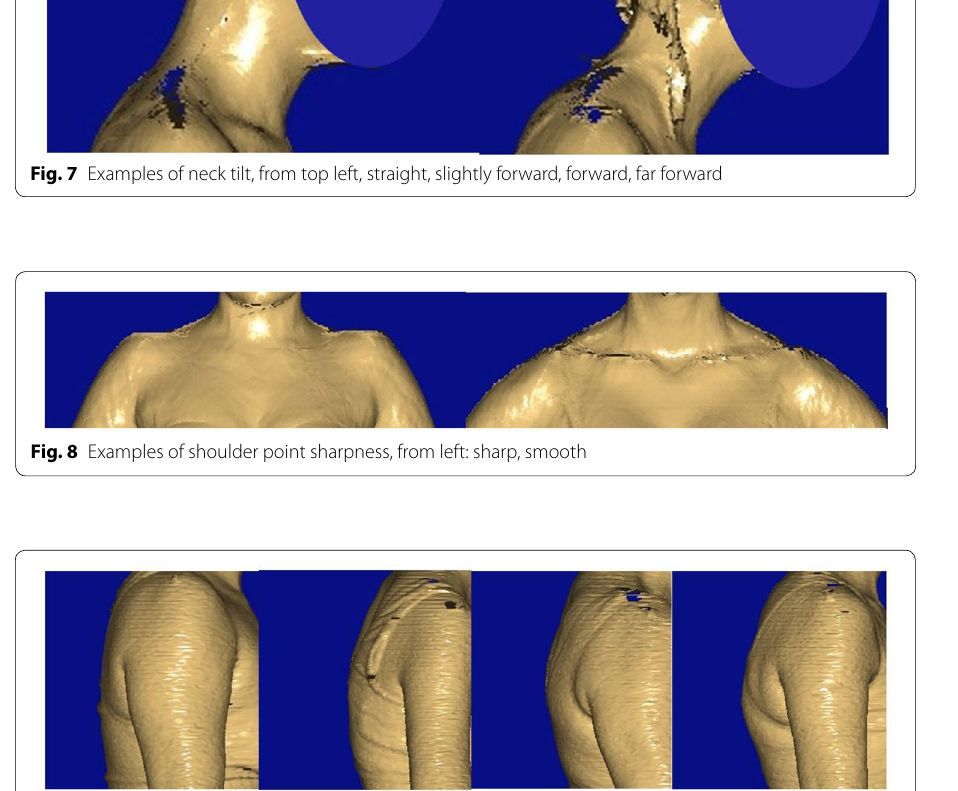
Fig. 9 Examples of shoulder blade prominence, from left: flat, almost flat, visible,